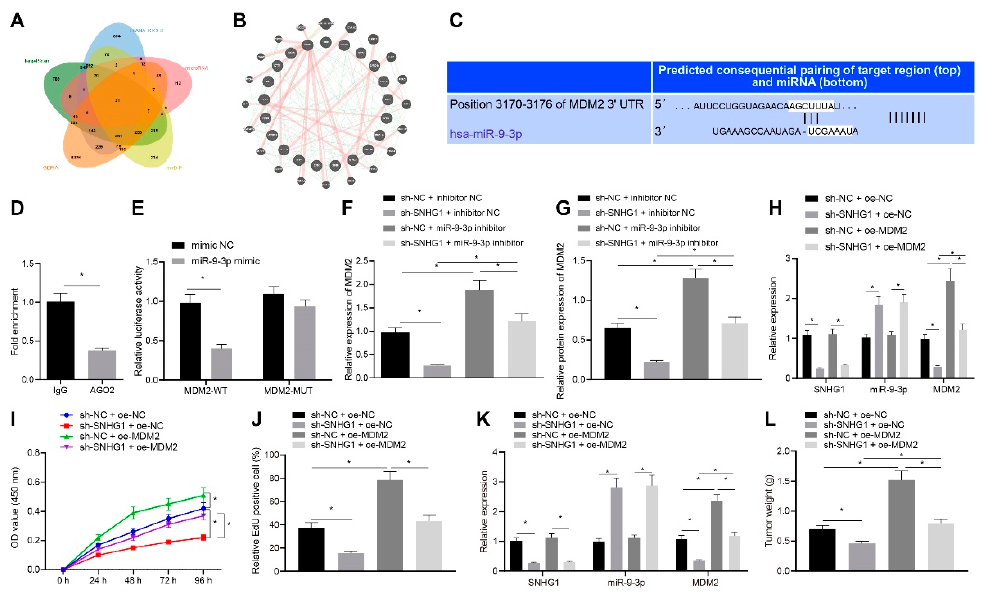
Figure 7. SNHG1 silencing decreases MDM2 expression via miR-9-3p to repress bladder cancer cell proliferation and tumorigenesis. ( A ) The downstream genes of miR-9-3p predicted by TargetScan: http://www.targetscan.org/vert_71/ (accessed on 8 August 2021), DIANA TOOLS: http://diana.imis.athena-innovation.gr/DianaTools/ (accessed on 8 August 2021), microRNA: http://www.microrna.org/microrna/home.do (accessed on 8 August 2021), and mirDIP: http://ophid.utoronto.ca/mirDIP/ (accessed on 8 August 2021). ( B ) The differential genes in bladder cancer obtained by GEPIA analysis of TCGA database. ( C ) Binding sites between miR-9-3p and the 3 (cid:48) UTR of MDM2 predicted by TargetScan website. ( D ) RIP experiment finding that AGO2 could pull down MDM2. ( E ) Targeting relationship between miR-9-3p and MDM2 assessed by dual-luciferase reporter gene assay. ( F ) The expression of MDM2 in T24 cells after silencing both SNHG1 and miR-9-3p detected by qRT-PCR. ( G ) The expression of MDM2 in T24 cells after silencing both SNHG1 and miR-9-3p detected by Western blot analysis. ( H ) The expression of SNHG1, miR-9-3p and MDM2 after overexpressing MDM2 and silencing SNHG1 in T24 cells measured by qRT-PCR. ( I ) CCK-8 assay of the change of T24 cell viability. ( J ) The changes of T24 cell proliferation detected by EdU assay. ( K ) qRT-PCR detection of the expression of SNHG1 and miR-9-3p in T24 cells. ( L ) Tumor weight. * p < 0.05. N = 10 mice in each group. The cell experiment was repeated three times. Data were presented as mean ± standard deviation and compared by one-way analysis of variance or unpaired t